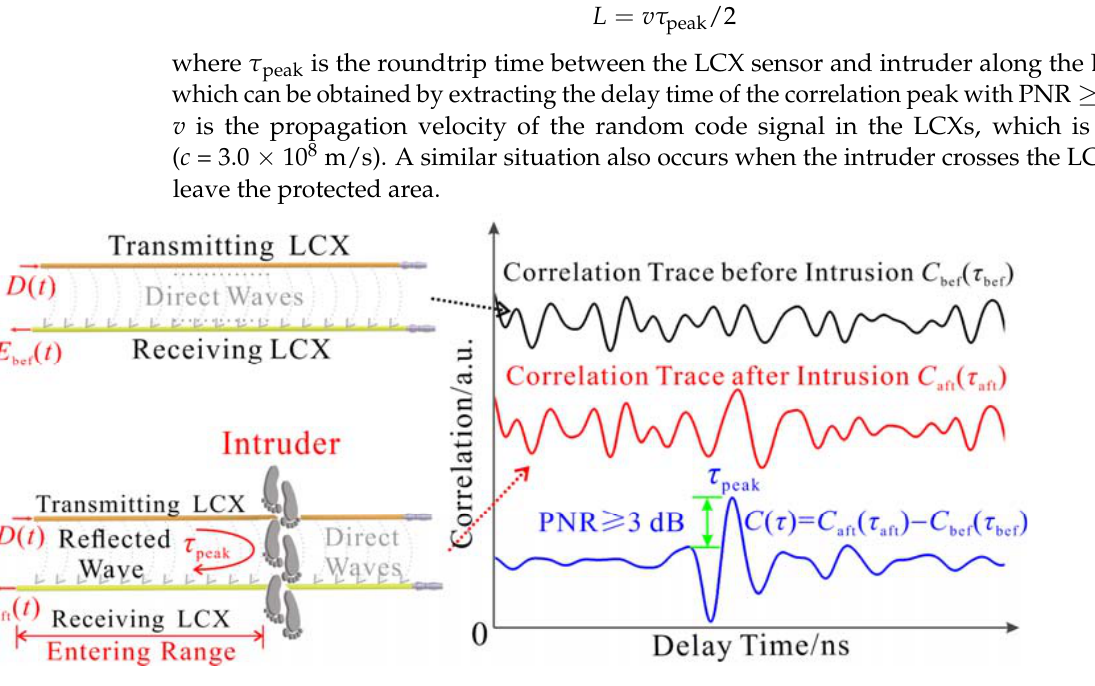
Figure 6. Measurement principle of early alarm.